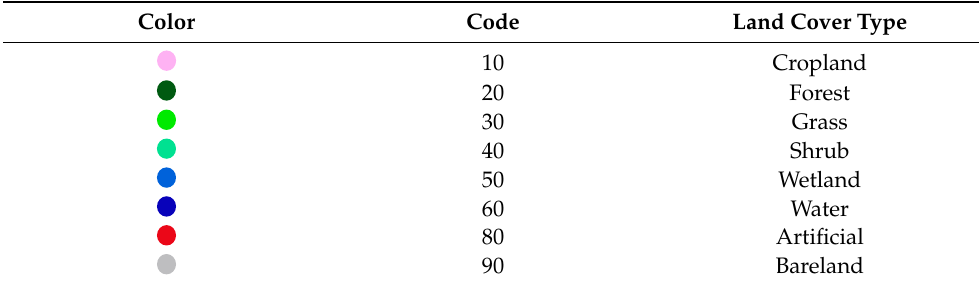
Figure 5. Transiogram models ( a ) cultivated land-others; ( b ) forest-others; ( c ) grassland-others; ( d ) wetland-others; ( e ) water-others. Table 1. Land cover types and codes.